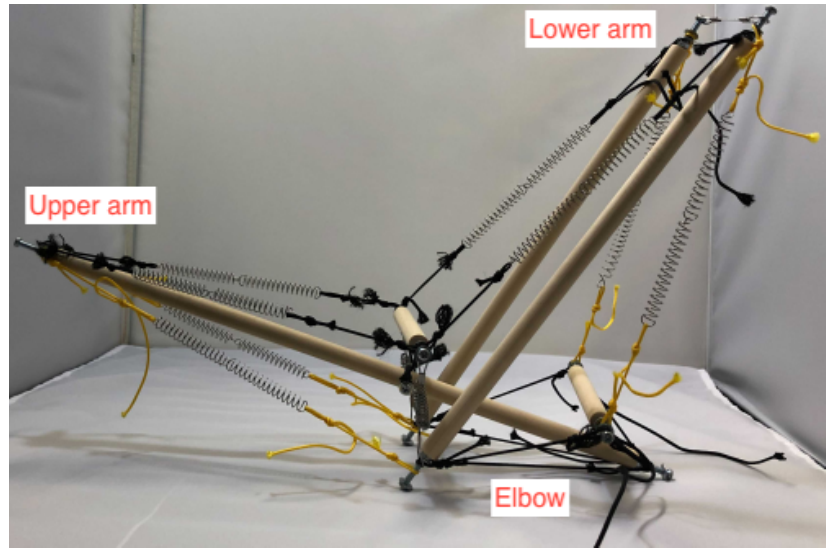
Figure 5. The developed tensegrity arm. The left side is the upper arm, the right side is the lower arm, and the center is the